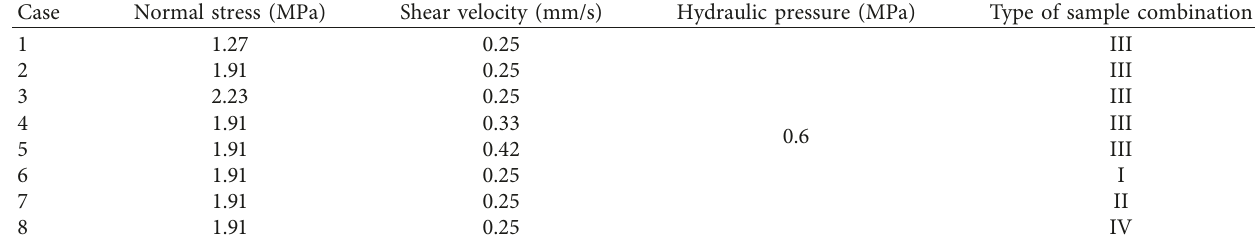
Table 4: Experimental